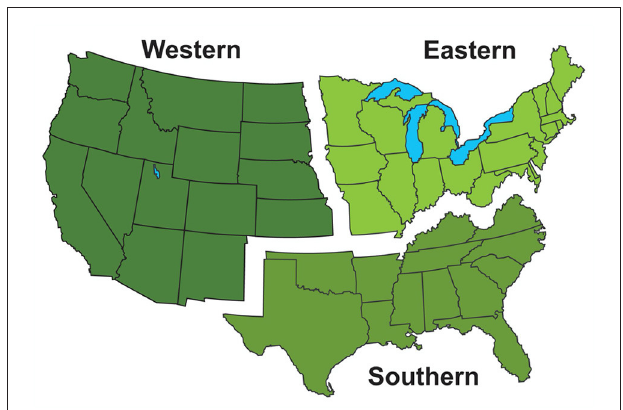
FIGURE 2 | Nursery and reforestation surveys were summarized based on three regions of the US. We lacked information on the area of reforestation opportunity in Alaska and Hawaii, so those states were excluded from this